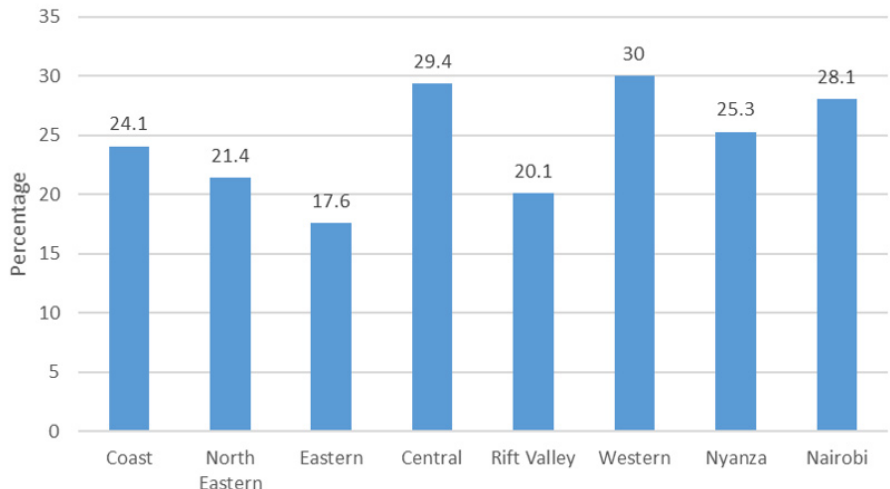
Figure 8. Percentage use of long-acting reversible contraception among modern contraceptives by region, 2014.